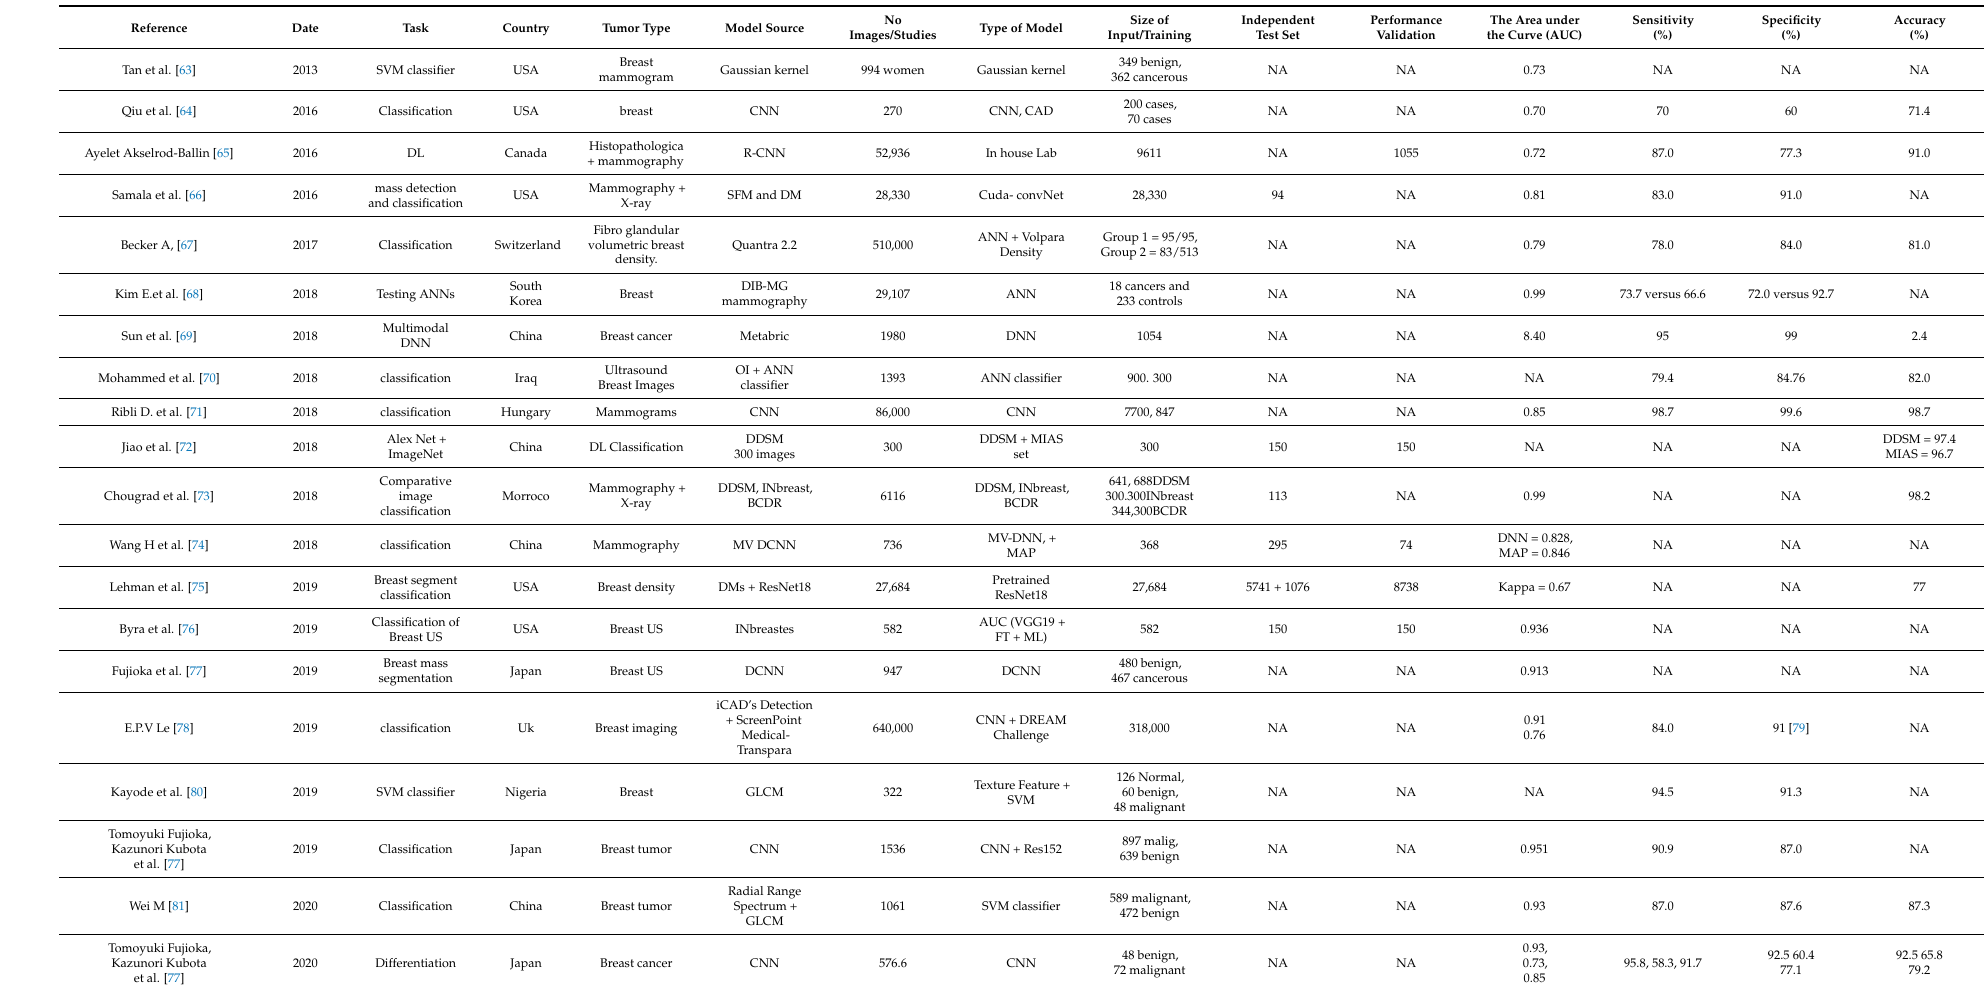
Table 2. Various algorithms of AI applications and performances in breast cancer